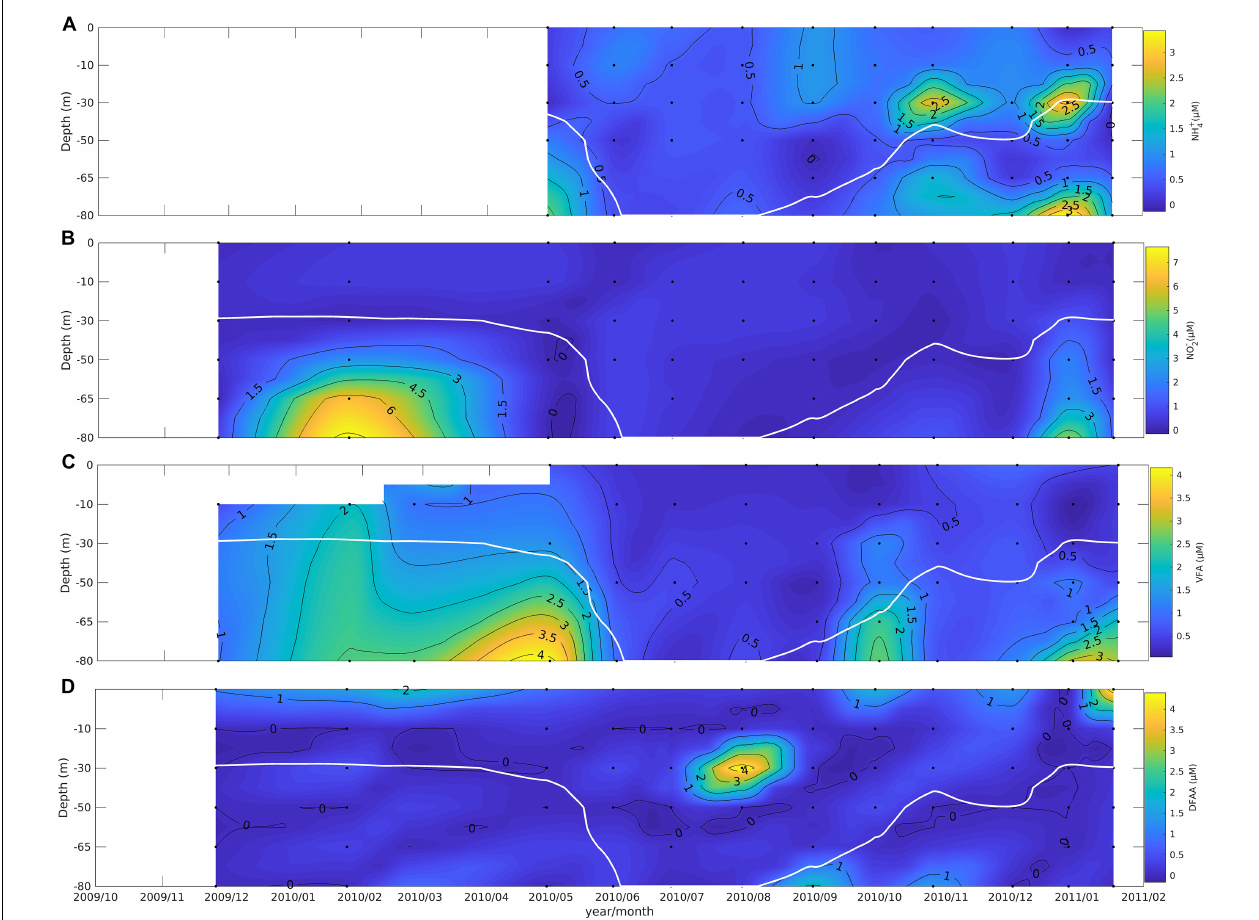
FIGURE 6 | Time series data from November 2009 through January 2011 in the water column at Station 18 off Concepción; (A) ammonium, (B) nitrite, (C) Volatile Fatty Acids, VFA (D) Dissolved Free Amino Acids, DFAA. The white line represents isopycnal of 26.5 in the core of